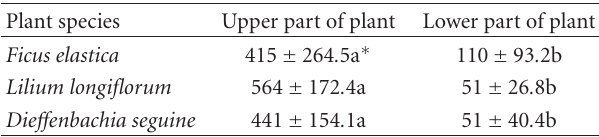
Table 1: Mean ( ± SD) number of P. longispinus on the upper and lower parts of three di ff erent plants. Note that there were no significant di ff erences within columns.